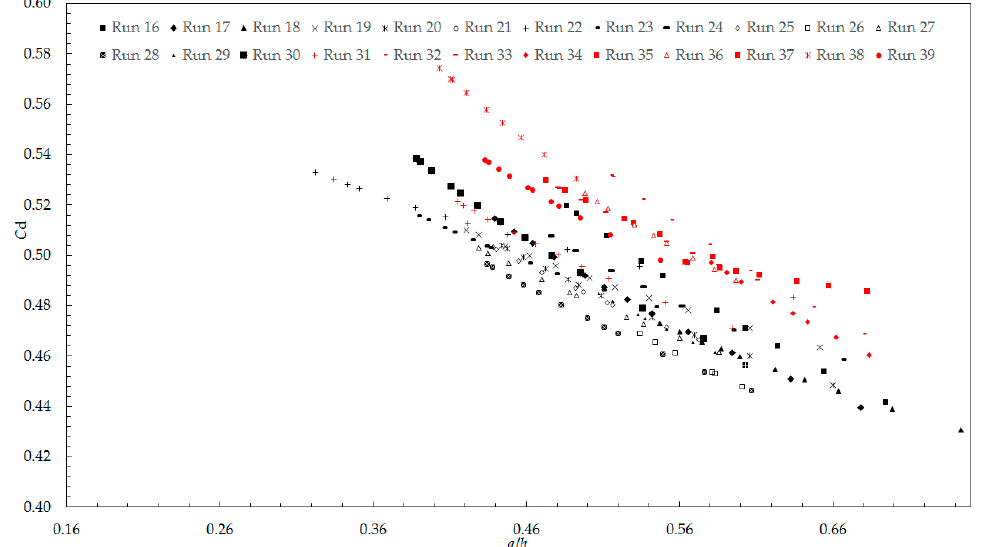
Figure 6. Discharge coefficients (C d ) versus a/h , Series 2.